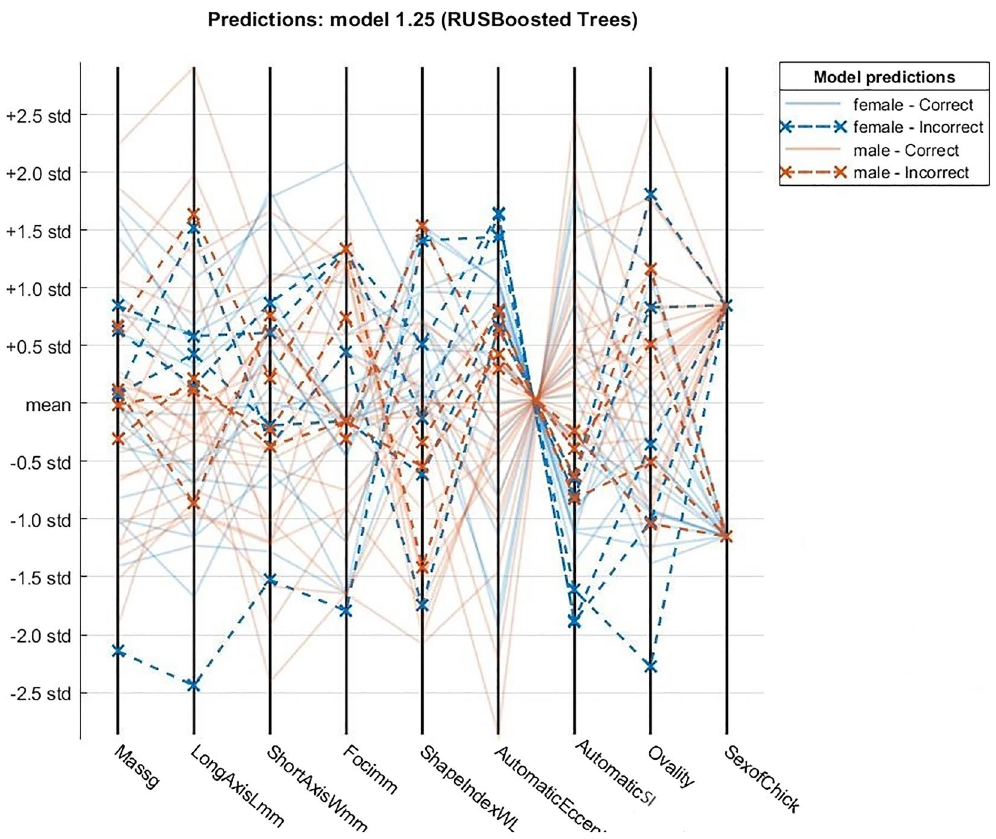
Figure 6. Parallel Coordinates Plot shows the relationship between variables. All features are